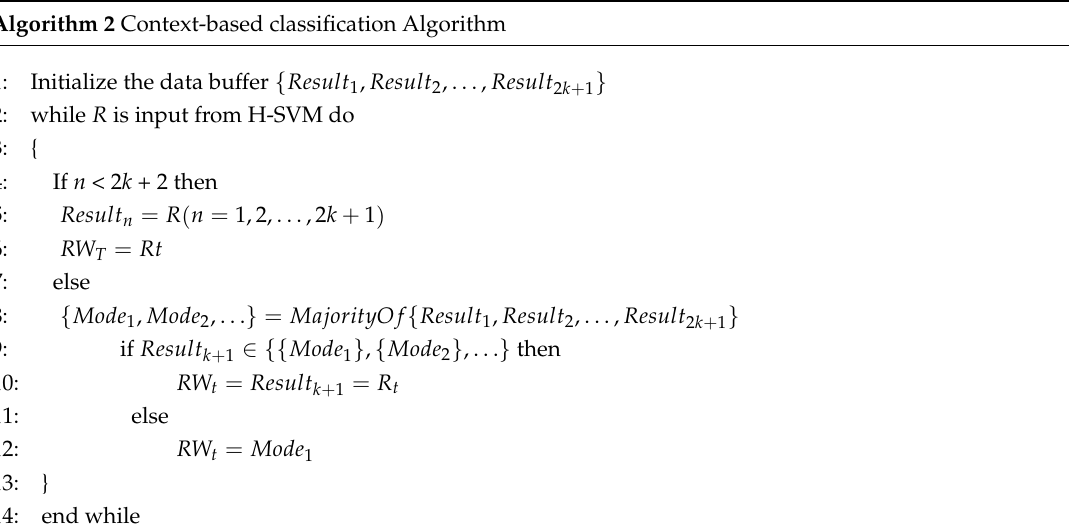
Algorithm 2 Context-based classification Algorithm